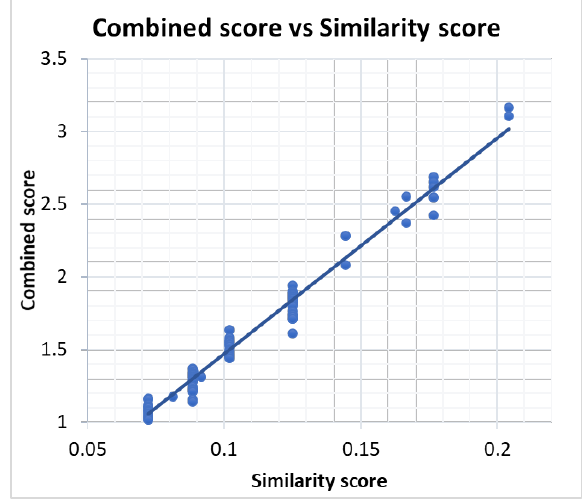
Figure 6. Relation between combined score and similarity score.